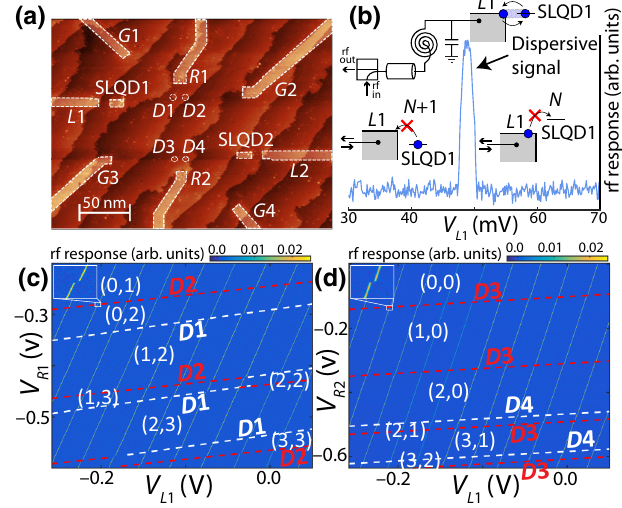
FIG. 1. Donor-based quantum dot device with integrated SLQD charge sensors. (a) STM image of the device and gate labels. SLQD1 is used to sense the donor quantum dots ( D 1, D 2, D 3, and D 4). Based on STM images and electrically measured charging energies, we estimate the number of 31 P donors in each to be two for D 1, three for D 2, three for D 3, and one for D 4. Elec- trons are loaded onto the donors from R 1 ( D 1, D 2) or R 2 ( D 3, D 4) and onto SLQD1 from L 1. A second SLQD (SLQD2) is not used in our experiments. (b) Schematic of SLQD charge-sensor operating principle. A quantum dot (SLQD1) tunnel coupled to an electron reservoir ( L 1) is embedded in a resonant circuit formed by a NbTiN superconducting spiral inductor, measured using standard reflectometry techniques [7]. When an ac excita- tion is applied to L 1, cyclical single-electron tunneling generates quantum capacitance in the circuit when the Fermi energy in L 1 is aligned with an available charge state of SLQD1. A change in the electrostatic environment causes the resulting Coulomb-like peaks to shift, allowing operation as a charge sensor. (c) Charge- stability diagram for D 1 and D 2 sweeping V L 1 and V R 1 . The periodic diagonal lines in the data are SLQD1 transition lines, with donor charge transitions from D 1 and D 2 being observed as breaks in the SLQD lines (example break shown in inset). The overlaid white dashed lines indicate D 1 charge transitions and the red dashed lines indicate D 2 charge transitions. (d) Charge- stability diagram for D 3 and D 4 sweeping V L 1 and V R 2 . The red dashed lines now indicate D 3 charge transitions, and the white dashed lines D 4 charge transitions. We note that here the D 3 and D 4 transition line slopes are similar; we identify the charge transitions by sweeping other gate